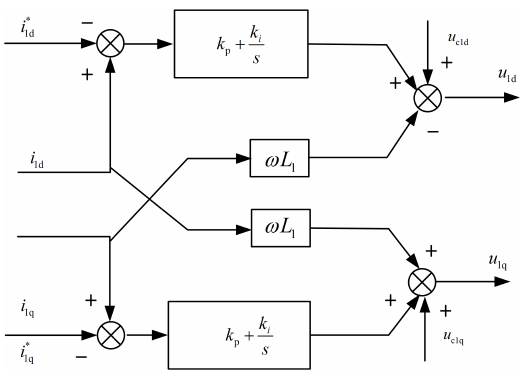
Fig. 5. Block diagram of PI